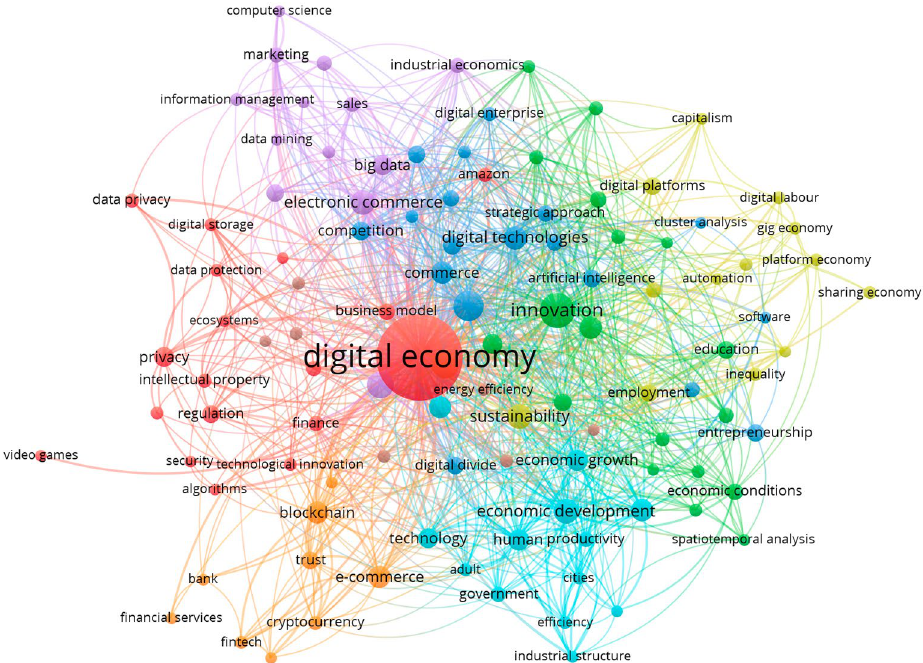
Figure 4. The visualization network of co-occurrence analysis in researching digital